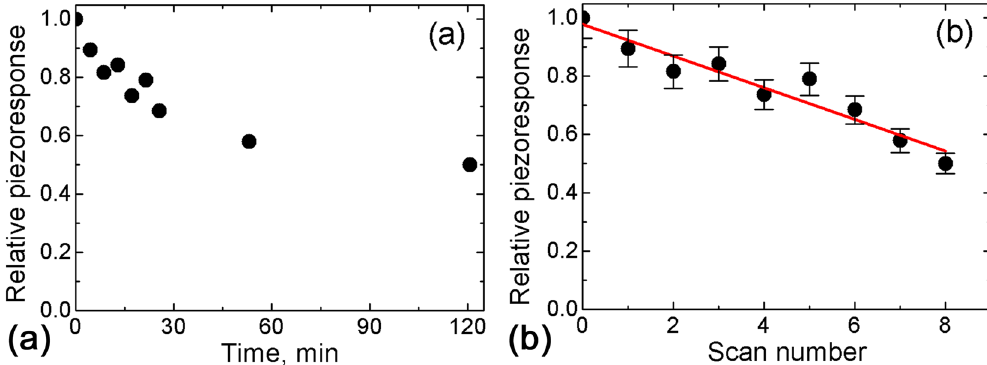
Figure 4. ( a ) Time and ( b ) scan number dependences of the relative PFM contrast for repeated scanning at room temperature after creation of polarized areas in SBN61. ( b ) Experimental points are fitted by a linear dependence. The poling voltage is U dc = 50 V.